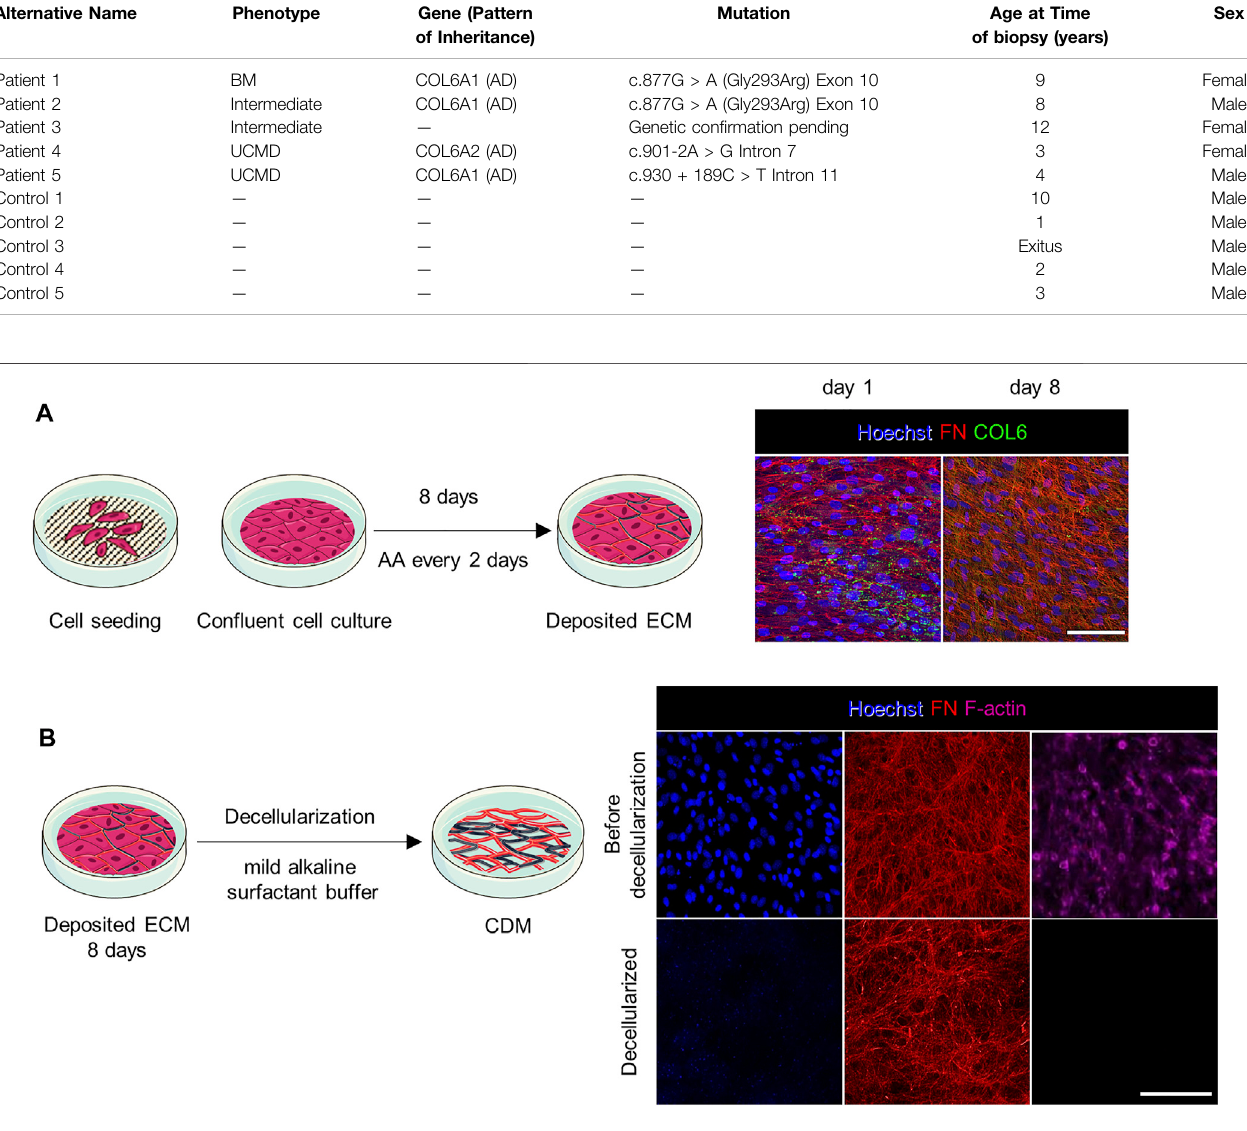
Frontiers in Bioengineering and Biotechnology |